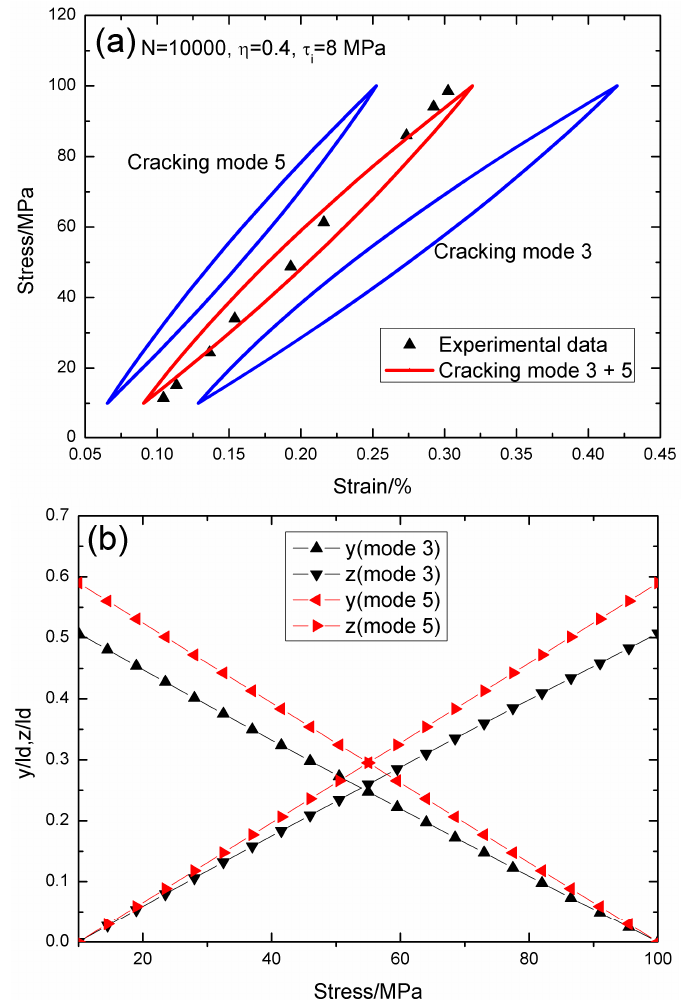
Figure 10. ( a ) The theoretical and experimental hysteresis loops; and ( b ) the interface slip lengths, i.e.